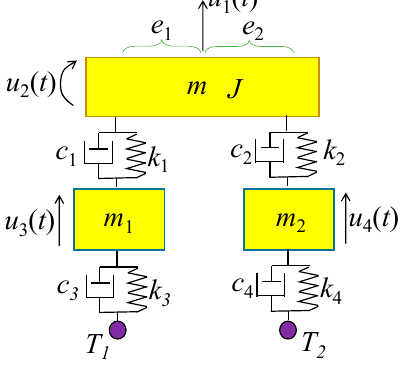
Figure 18. 4 ‐ DOF car model. Figure 18. 4-DOF car model.